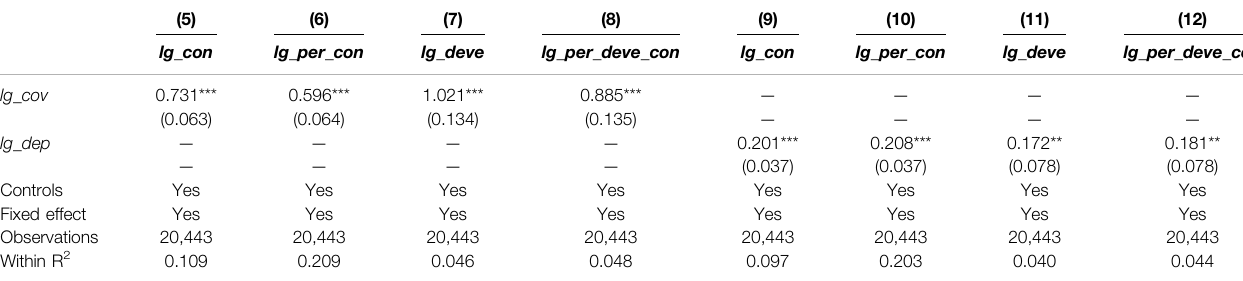
TABLE 3 | Impact of digital fi nance coverage breadth and usage depth on rural residents ’